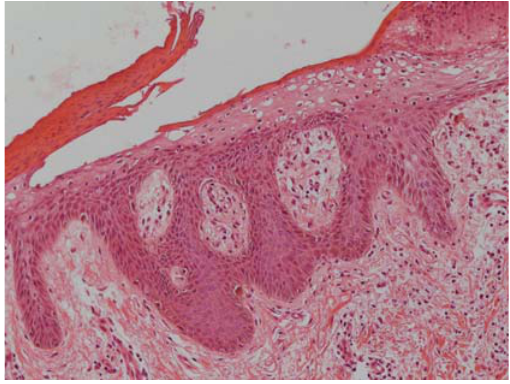
Figure 6 - Vacuolated, pale, swollen epidermal cells and necrosis of the superficial